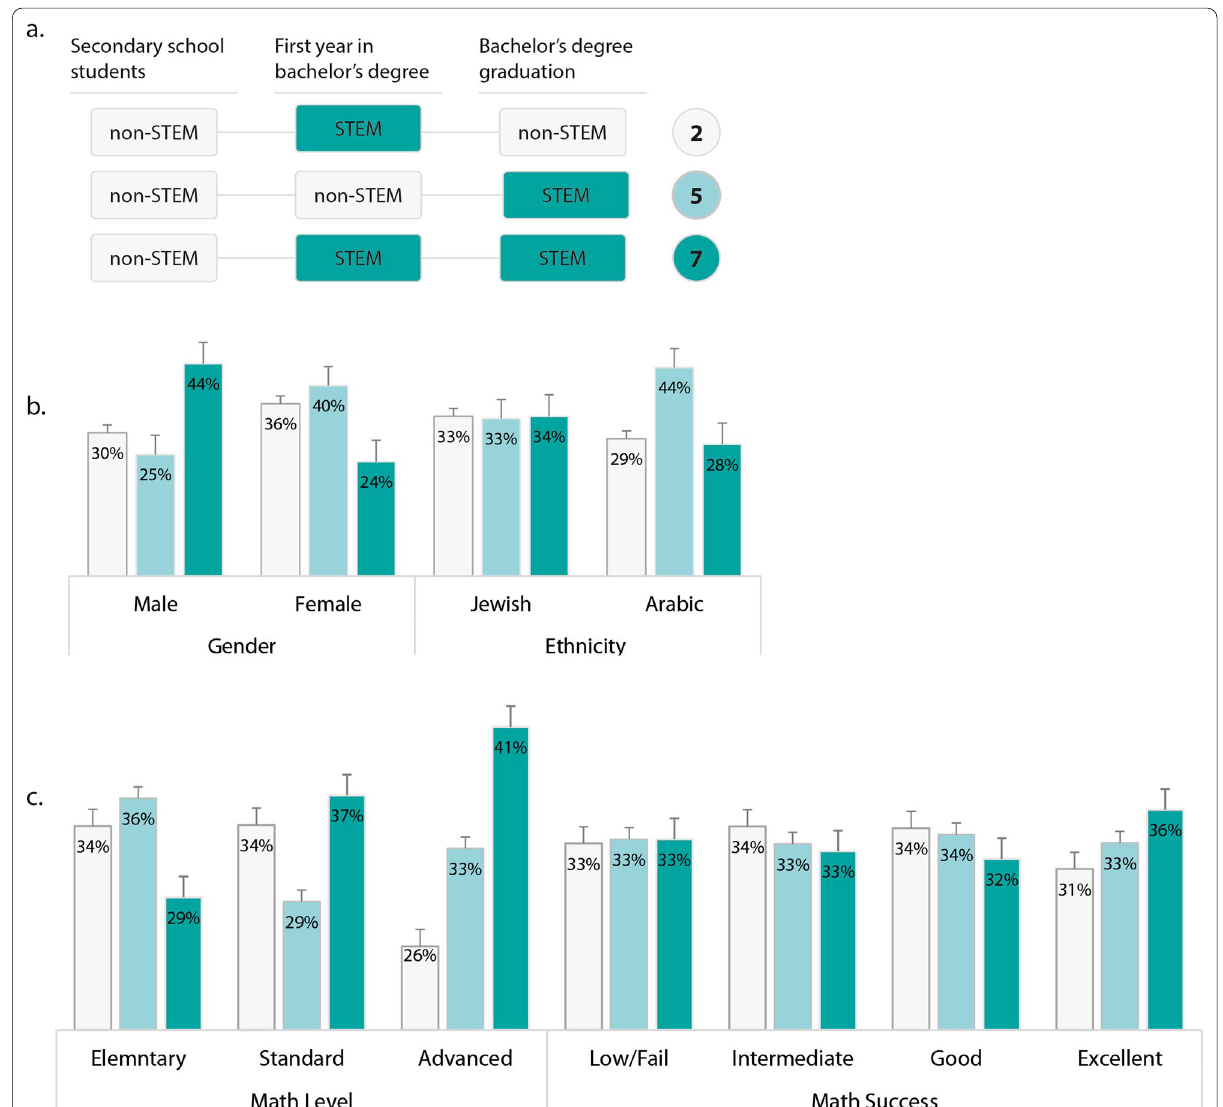
Fig. 9 The characteristics of the pathways begin with a non‑STEM secondary major: a illustration of the relevant pathways, #2, #5, and #7; b the distribution of the demographic characteristics between these pathways; c the distribution of the educational characteristics in mathematics between these